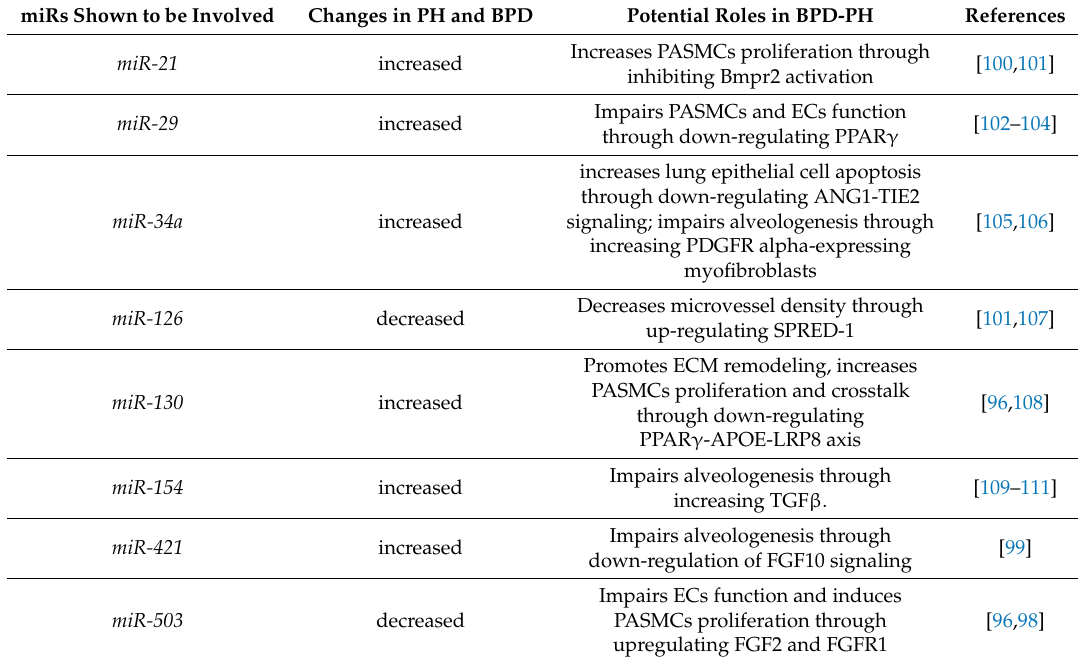
Table 1. MicroRNAs (miRs) potentially involved in pulmonary vascular remodeling in